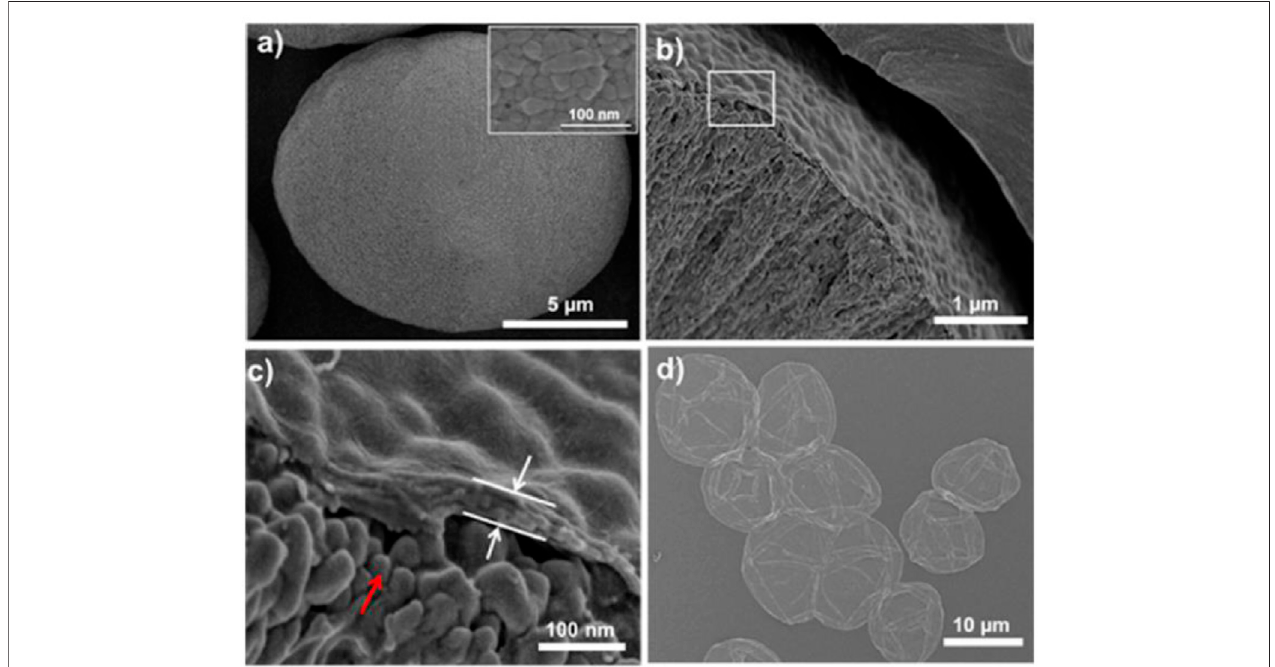
FIGURE 2 | The SEM images of (A) spherical CaCO 3 microparticles. The inset: details of the CaCO 3 surface. (B) Cross-section of CaCO 3 (AP/CNF) 5 AP/XyG microparticles, and (C) is a higher magni fi cation of (B) . The red arrow points to the surface morphology of CaCO 3 microparticles. The white arrows point to the AP/CNF multilayer. (D) The SEM image of (AP/CNF) 5 AP/XyG microcapsules after core removal (Paulraj et al.,